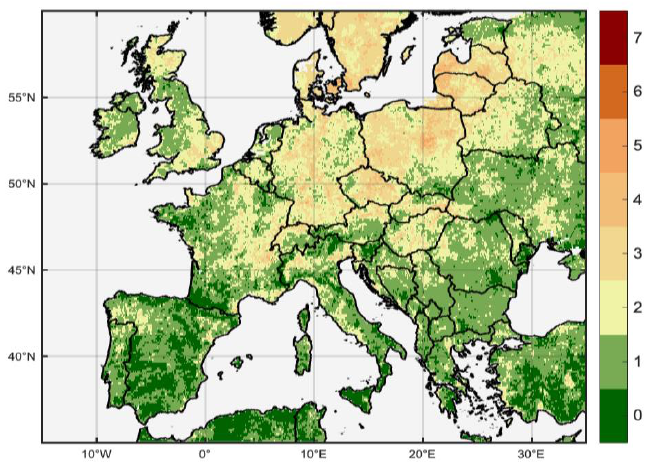
Figure 7. As in Figure 4 but considering MODIS LST (MYD11). Finally, the NHD (i.e., number of days where LST exceeded the 90th percentile for that pixel) are shown in Figure 8. Similar to the results obtained with MSG, a few hot days